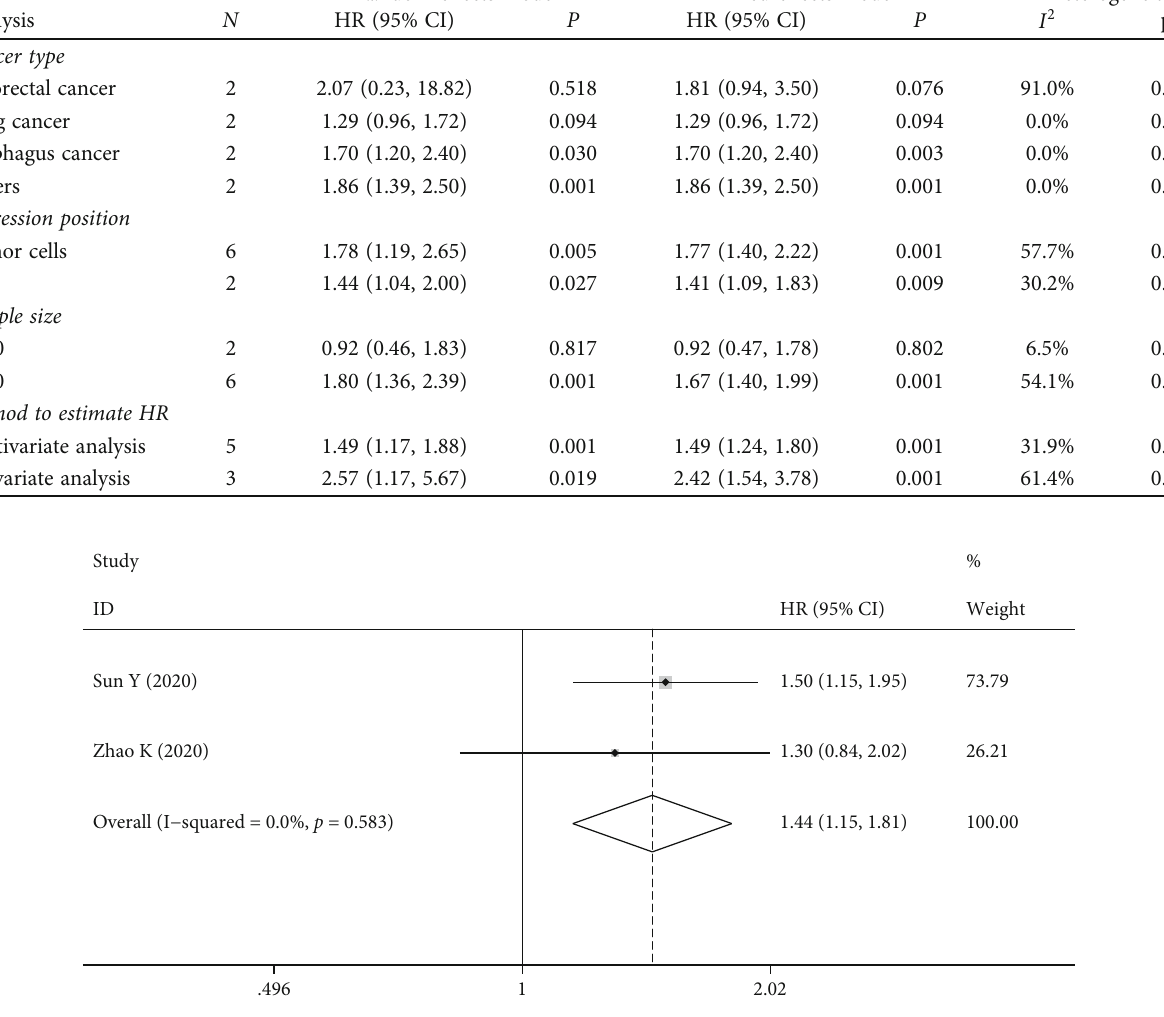
Figure 3: Forest plot for